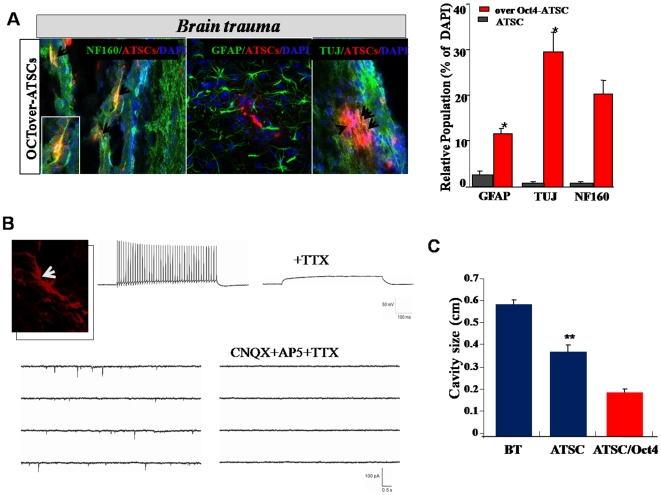
The therapeutic efficacy of engrafted Oct4/ATSCs in a mouse model of a traumatic brain injury.(A) High neuroregenerative potency of Oct4/ATSCs in injured lesion of traumatic mouse brain. The arrows indicate engrafted and functionally transdifferentiated neurons in the hippocampus. (B) Electrophysiological properties of transdifferentiated neuron from engrafted Oct4/ATSCs from a lesion of traumatic injured brain slice. Whole-cell patch-clamp recordings of engrafted Oct4/ATSCs in traumatic brain slice. The presence of the ionic currents was first investigated by applying voltage ramps between 120 and 120 mV to the cells patch clamped using K-based pipette solution. ATSCs control engrafted brain slice does not display inward current, whereas Oct4/ATSCs engrafted brain slice actively produced a current. This current was approximately 75% blocked by 30 nM tetrodotoxin (TTX), although 300 nM TTX blocked it completely. Oct4/ATSCs engrafted brain slice express voltage-gated Na channels. Voltage-clamp recording at70 mV in extracellular solution containing 3 mM Mg2. Traces show spontaneous slow and fast currents that indicate that this transplanted Oct4/ATSCs receives synaptic contacts from host cells. This current was approximately 98% blocked by CNQX AP5 solution. (C) The Oct4/ATSCs engrafted traumatic brain demonstrated that there was a decrease in the lesion cavity size.